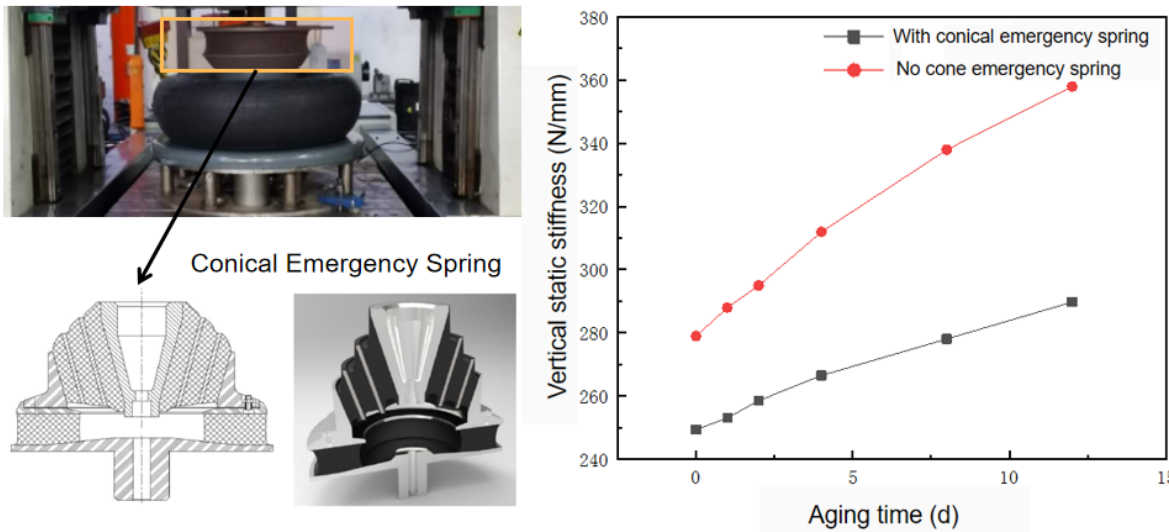
Figure 11. Vertical static stiffness of air spring with and without conical emergency spring during aging.